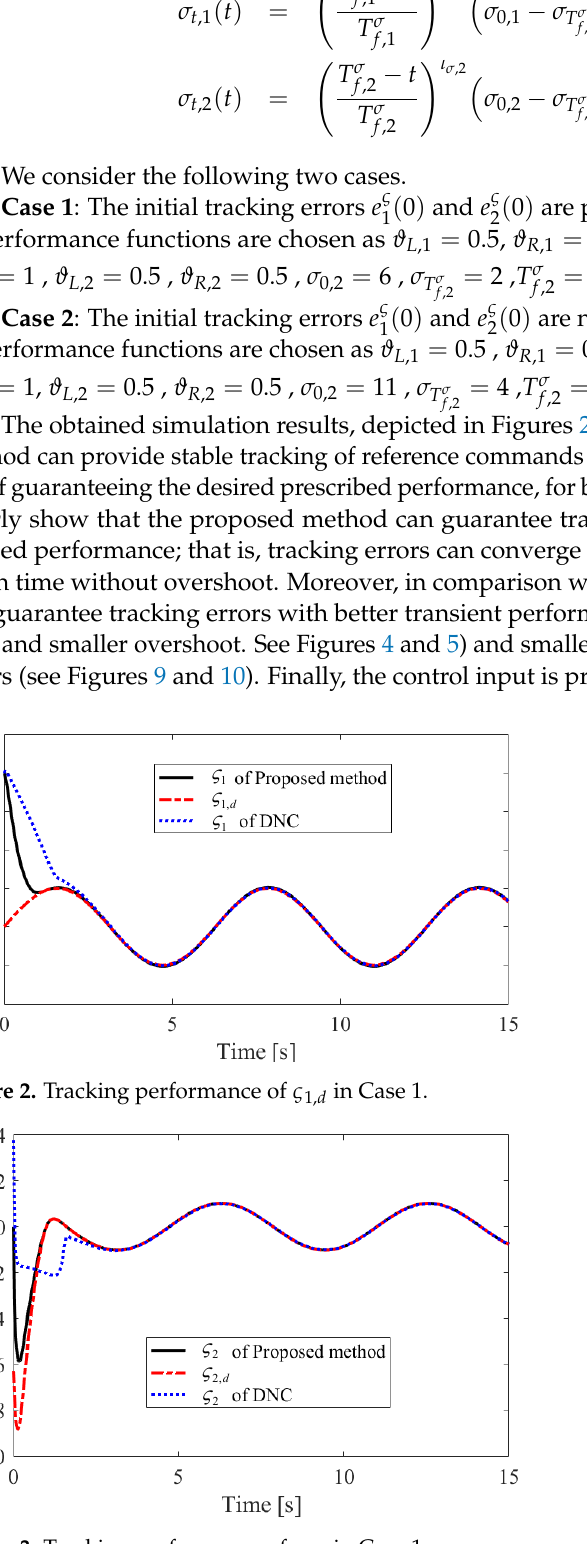
Figure 3. Tracking performance of ς 2, d in Case